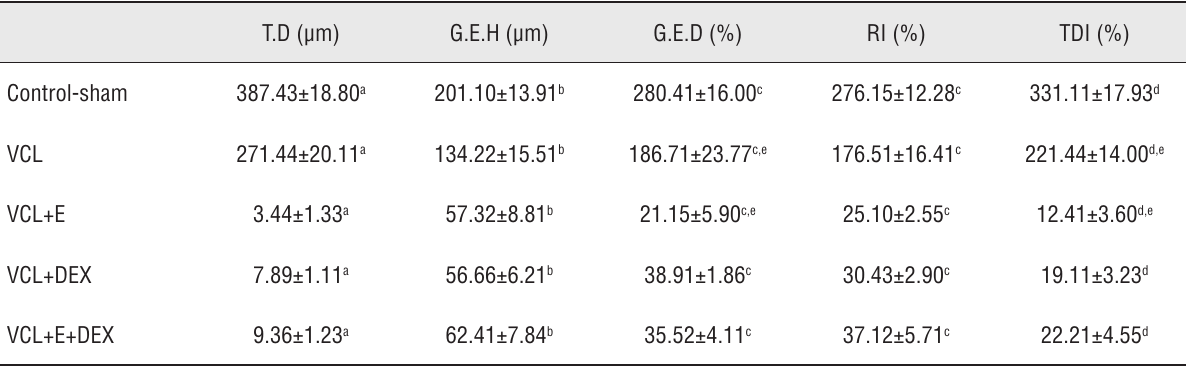
Table 1 - Summary of histological analyses; all data are given as Mean±SD (n=6). T.D (µm) G.E.H